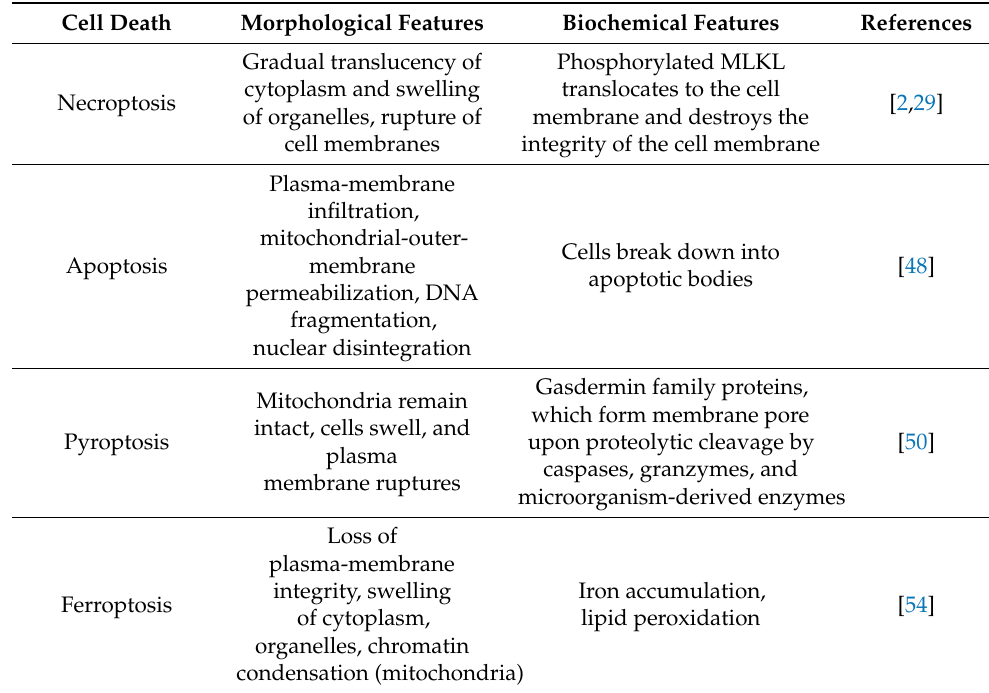
Table 1. Comparison of Necroptosis with Other Forms of Cell Death. Cell